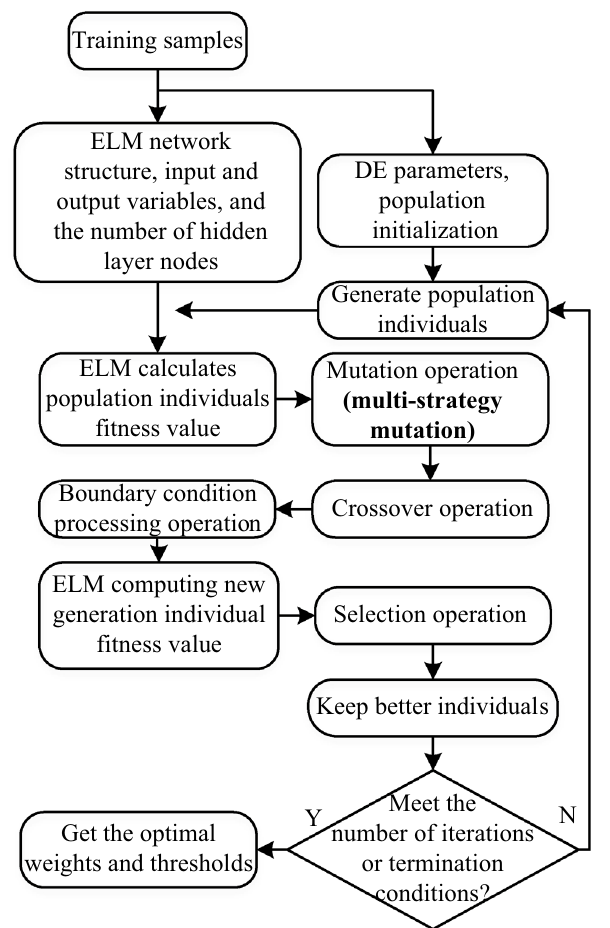
Figure 2. Optimized parameters of ELM with